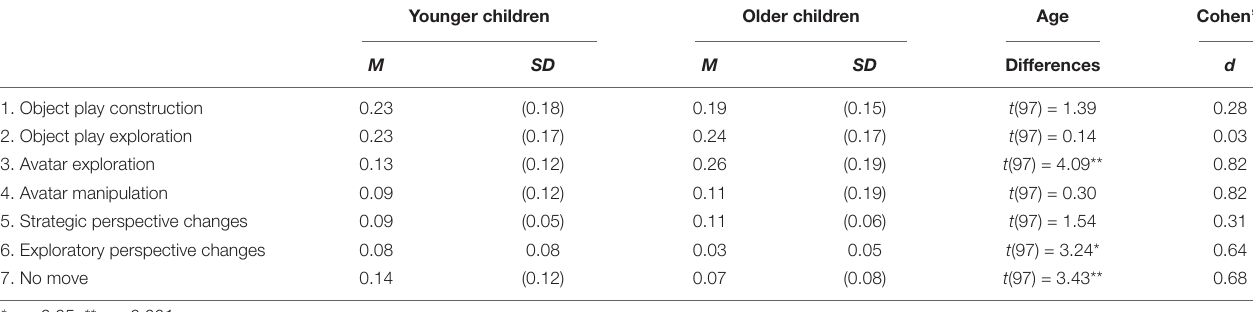
TABLE 4 | Means (and standard deviations) of and age differences in proportion of Toca Blocks play time children spent engaging in each type of play behavior.